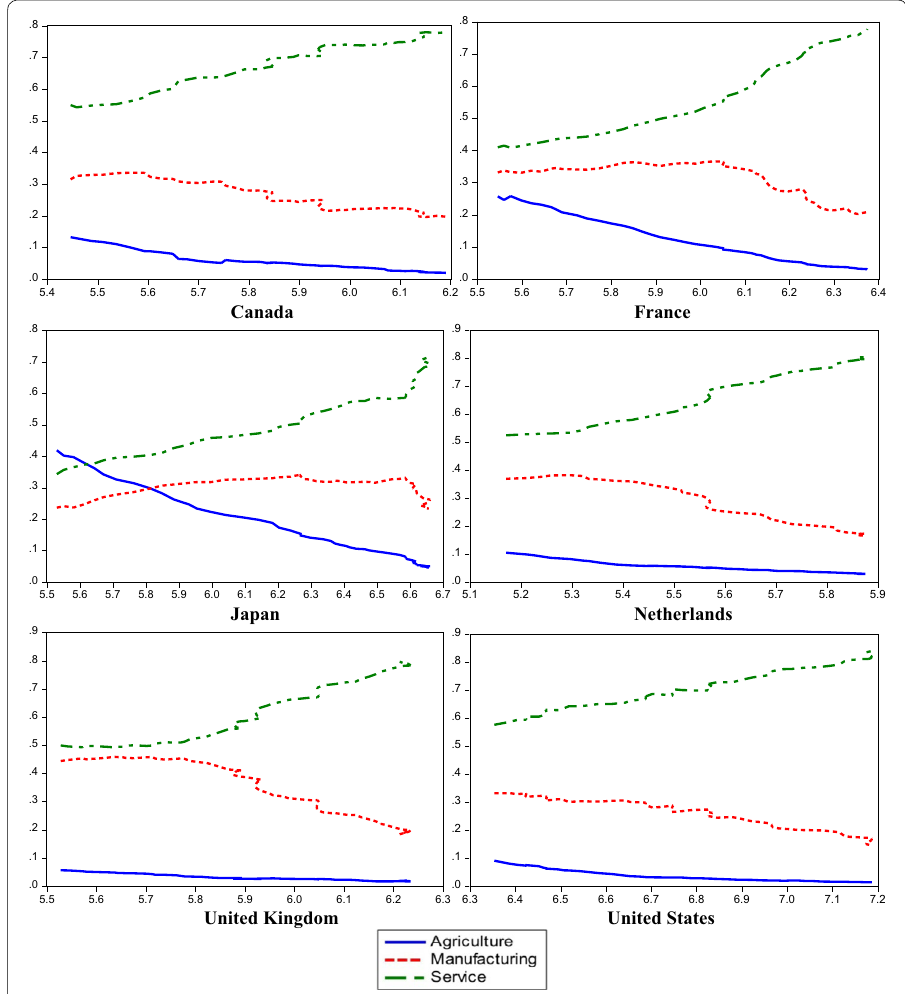
Fig. 1 Sectoral shares of workers in the three sectors, and GDP in developed countries. Note : Horizontal line is Log (real GDP in national currency). Source : Author’s calculations. Various sources were used to collect data. For Canada, employment data were collected from Federal Reserve Bank of St. Louis for the period of 1960– 2014. Employment data in the major developed countries was derived from Groningen Growth and Develop- ment Centre: for France, the period 1950–2011; for Japan the period 1953–2012; for Netherlands the period 1959–2011; for the United Kingdom the period 1948–2011; for the United States the period 1950–2010. Real GDP (national currency) of all countries was derived from Federal Reserve Bank of St.